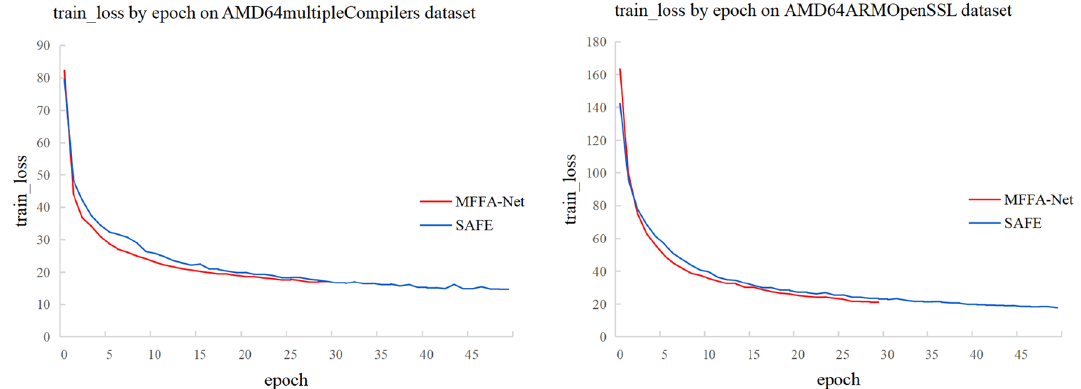
Figure 6. Training loss